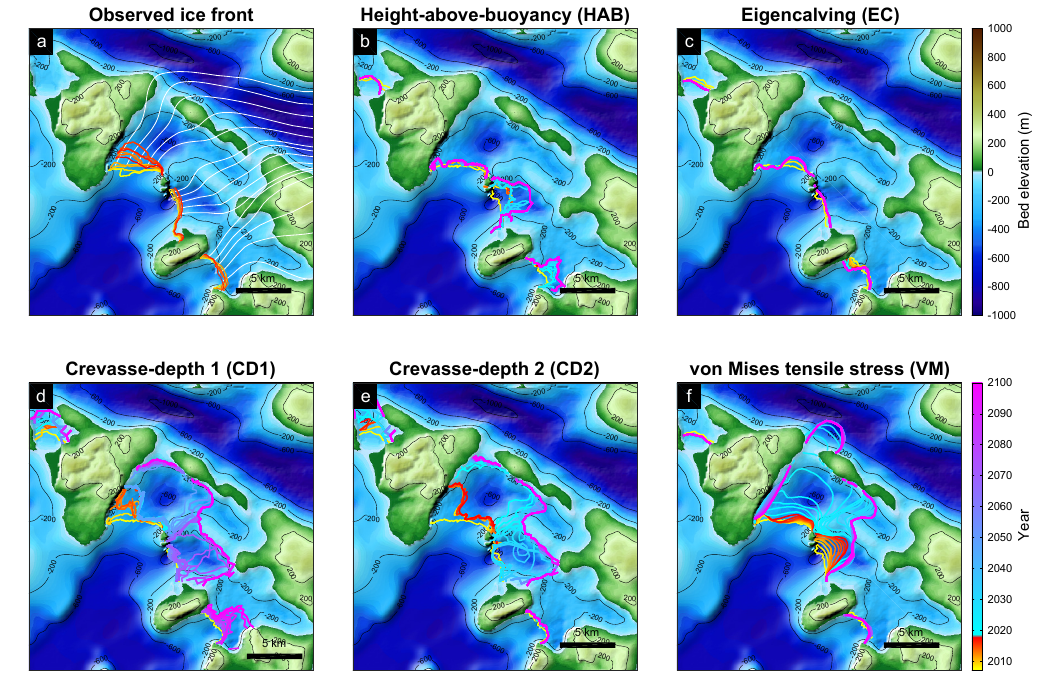
Figure 3. Same as Fig. 2 but for Hayes